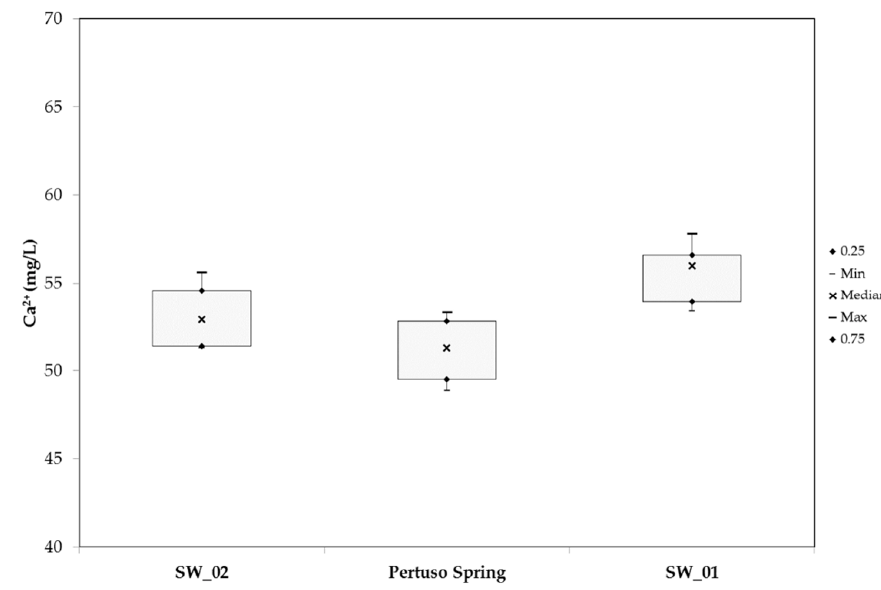
Figure 10. Box plot of mean, median, maximum, and minimum values of calcium distribution.